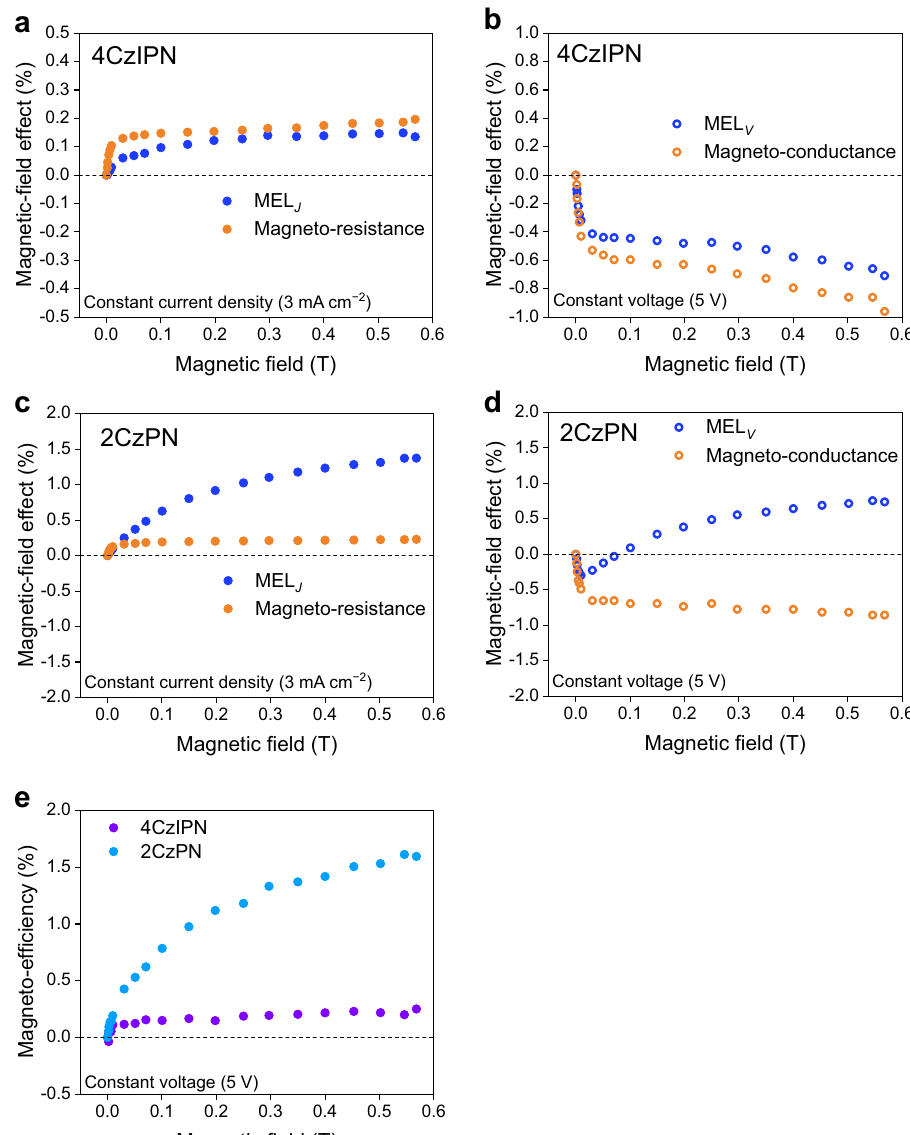
Fig. 2 Magnetic fi eld effects on device characteristics of pristine TADF-OLEDs. a Magnetic responses in device characteristics of 4CzIPN-based OLED under constant current density of 3.0 mA cm − 2 . b Magnetic responses in device characteristics of 4CzIPN-based OLED under constant voltage of 5 V. c Magnetic responses in device characteristics of 2CzPN-based OLED under constant current density of 3.0 mA cm − 2 . d Magnetic responses in device characteristics of 2CzPN-based OLED under constant voltage of 5 V. e Magneto-ef fi ciencies of 4CzIPN-based and 2CzPN-based OLEDs under constant applied voltage of 5